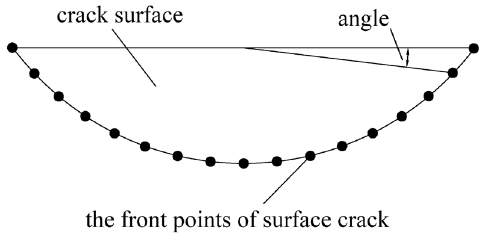
Figure 6. The angle between the front points of the surface and flange plate